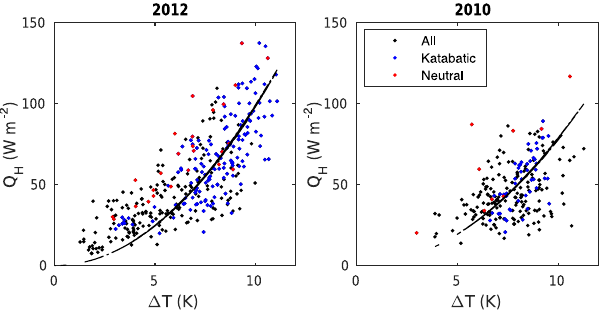
Figure 10. Observed 30min sensible-heat flux ( Q H ) vs. observed air–surface temperature difference ( (cid:49)T ), and modeled 30min Q H fluxes (black line) according to the C kat method, for the 2012 and 2010